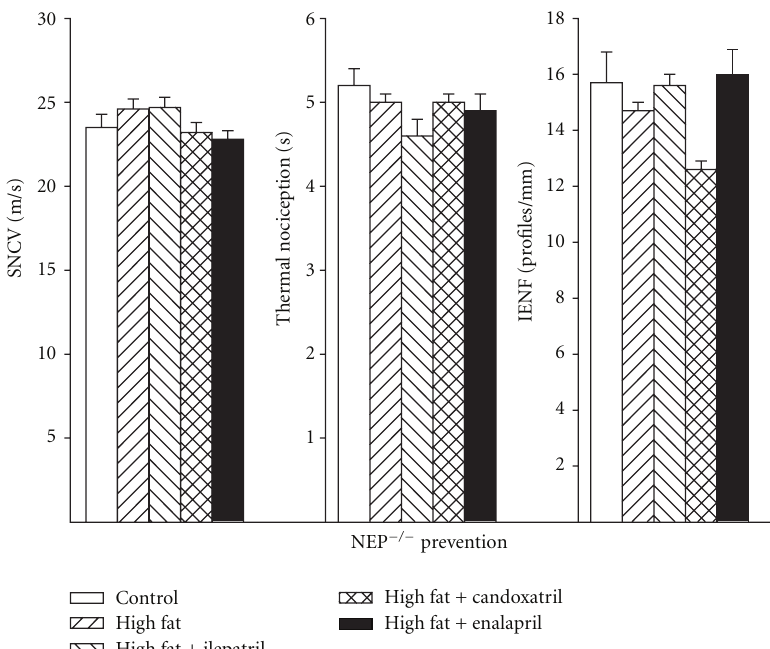
Figure 6: Sensory nerve conduction velocity, thermal nociception, and intraepidermal nerve fiber profiles for NEP − / − mice fed a normal or high-fat-containing diet with or without ilepatril, candoxatril, or enalapril for 12 weeks (prevention protocol). Control (open bar), high fat (right hatch bar), high fat + ilepatril (left hatch bar), high fat + candoxatril (cross hatch bar), and high fat + enalapril (closed bar). Data are the mean ± SEM. The number of mice in each group was the same as shown in Table 1. a, P < 0 . 05 versus control; b, P < 0 . 05 versus high-fat-fed